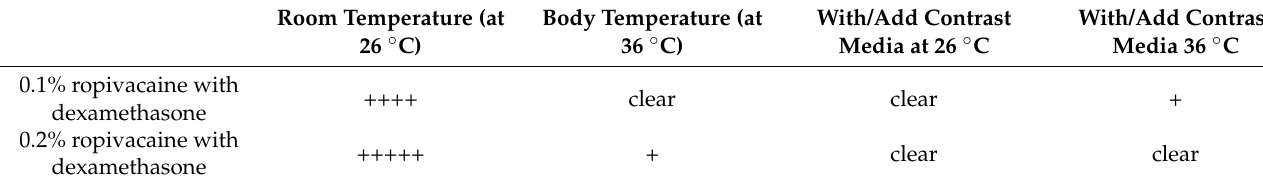
Table 1. Subjective microscopic assessment of the particulates.